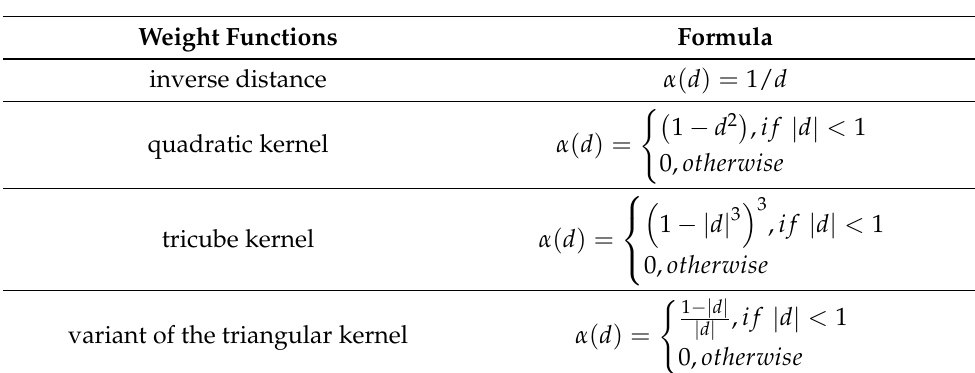
Table 2. Weight functions. Weight Functions